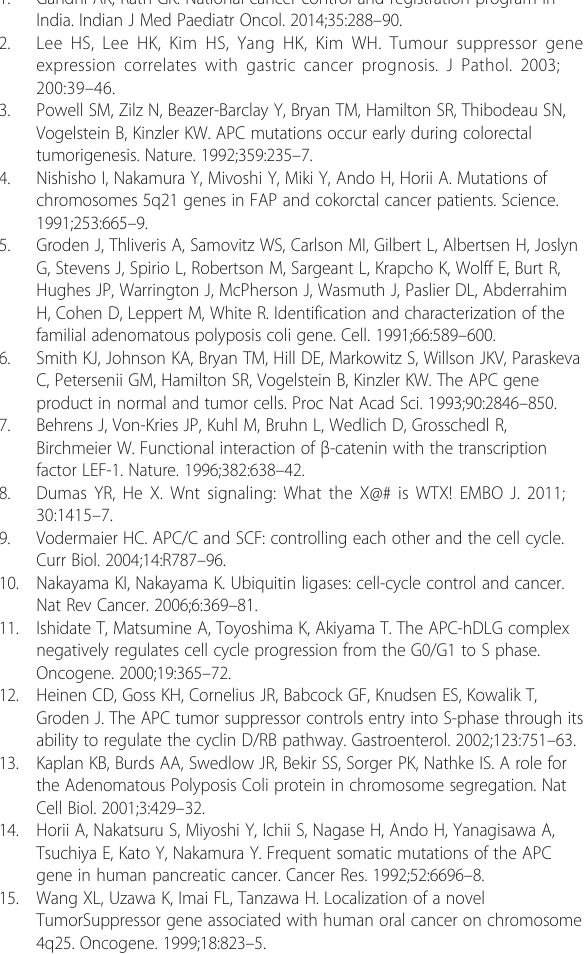
Additional file 1: Figure S1. (A) PCR-RFLP of APC gene Exon 14 (M – 100 bp marker; S1, S2 – Normal alleles; S3, S4 – Mutant alleles); (B) SSCP analysis of APC gene exon 15A.b. (1, 2 – Healthy Control; 3,4,5,6 – Tumour tissues; 7, 8 – Matched tissues). Figure S2. Exon 15 non-synonymous mutation positions in the APC protein (DOCX 856